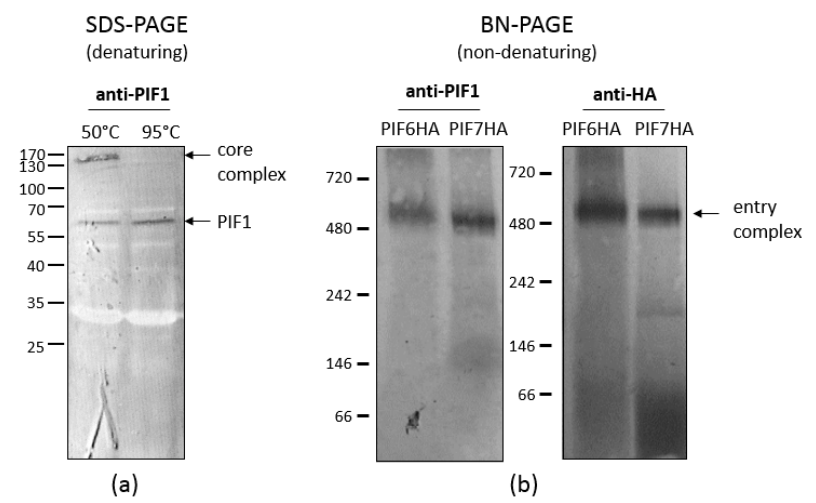
Figure 4. Detection of the stable core complex and the entry complex. ( a ) When isolated occlusion-derived viruses (ODVs) were analysed under denaturing conditions by incubation in Laemmli buffer at 50 °C, the core complex was found as a 170 kDa band by western blot with PIF1 antiserum. Under these conditions, also PIF1 monomers were detected at 60 kDa. When the ODVs were incubated at 95 °C, the core complex dissociated and only PIF1 monomers were found. ( b ) When isolated ODVs were analysed under non-denaturing conditions, the entry complex was detected as a band of approximately 480 kDa with antiserum against PIF1 (left panel) and with anti-HA antibodies against HA-tagged PIF6 (right panel). When analysing ODVs that contain HA-tagged PIF7 with anti-HA antibodies, the entry complex was also found, indicating that PIF7 is part of this complex (right panel).